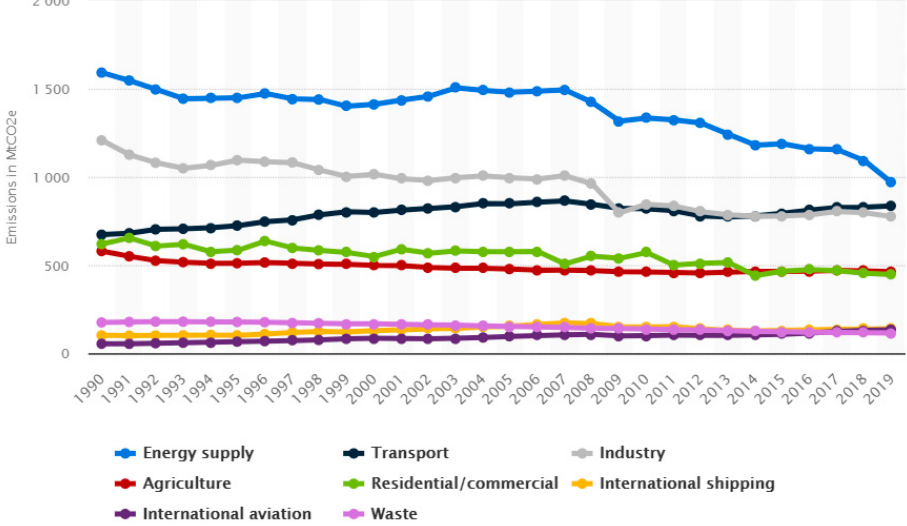
Figure 1. Annual greenhouse gas emissions in the European Union from 1990 to 2019, by sector (in million metric tons of CO 2 -equivalent) [12].